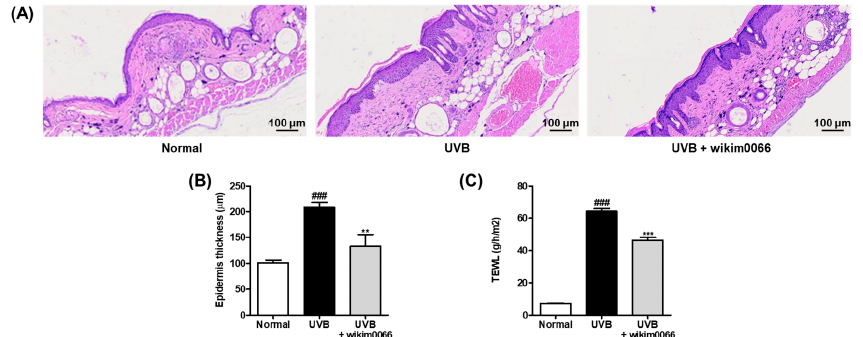
Figure 6. Effect of wikim0066 administration on histological representative image of dorsal skin section ( A ), epidermis thickness ( B ), and TEWL ( C ) in UVB-irradiated hairless mice. Epidermal thickness was measured by H&E staining using a microscope at 100 × magnification. HR-1 hairless mice were orally administrated wikim0066 (1 × 10 9 CFU/head) three times a week for 12 weeks with UVB irradiation. Results are expressed as mean ± SEM ( n = 6). ### p < 0.001 vs. normal, and ** p < 0.01, *** p < 0.001 vs. UVB-control.